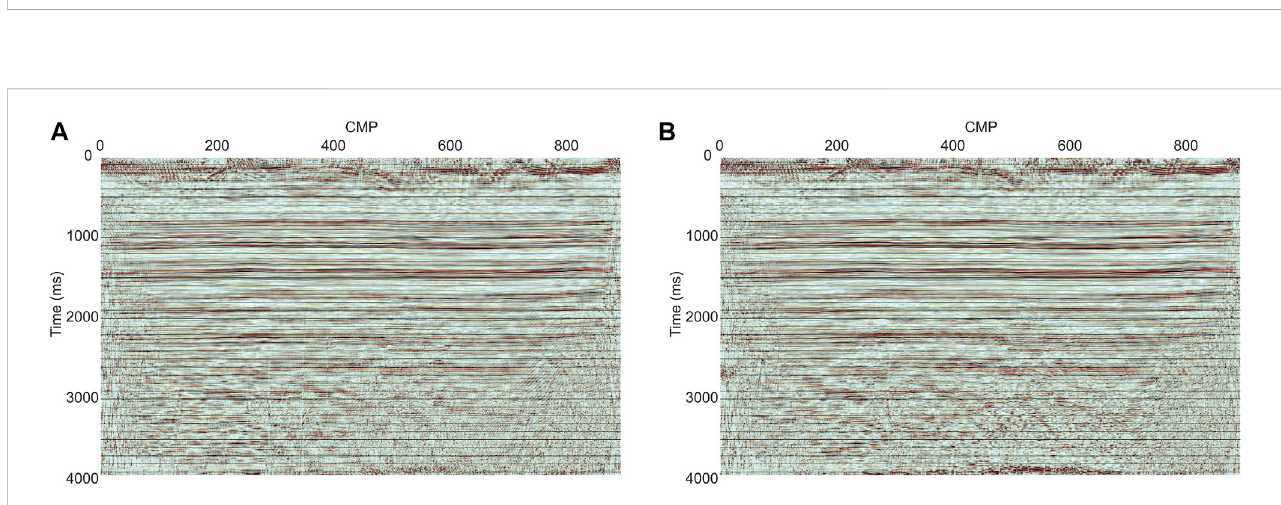
FIGURE 12 Seismic re fl ection images (A) without and (B) with the trained U-net applied in the processing fl ow. With the U-net denoising step included in the processing fl ow, the seismic re fl ection image is clearer below 2000 m and less affected by the pumpjack noise. Between 200 and 400 CMP, some vertical discontinuities caused by the pumpjack noise are suppressed by the U-net